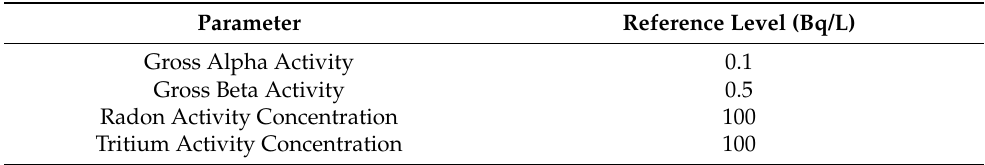
Table 4. Reference levels for activity concentration of radiological parameters evaluated in drink- ing water